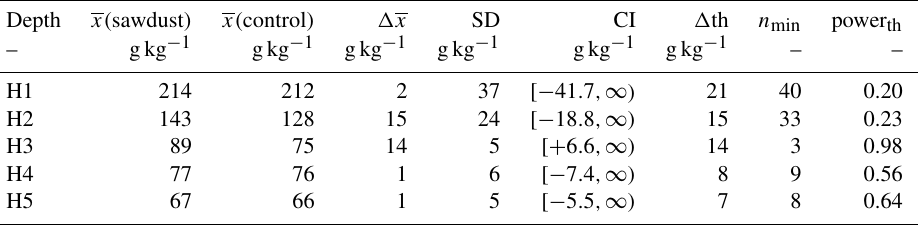
Table A3. The means of the OC concentrations ( x( sawdust ) , x( control ) ), their differences ( (cid:49)x ), and their pooled standard deviation (SD) are presented. The confidence interval (CI) is calculated from a t test (one sided, significance level α = 0 . 05, power 1 − β = 0 . 8, sample size 5, unpaired) to answer the alternative hypothesis that x( sawdust ) − x( control ) is larger than zero. The difference is significantly larger if the CI is >0. We also calculated the minimum sample size ( n min ) and power (power th ) for a theoretical difference ( (cid:49) th) between the sites to evaluate the power of our data. The (cid:49) th is either taken from (cid:49)x or assumed to be 10% of x( control )